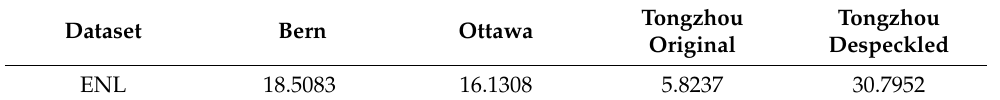
Table 1. The ENL of each dataset.